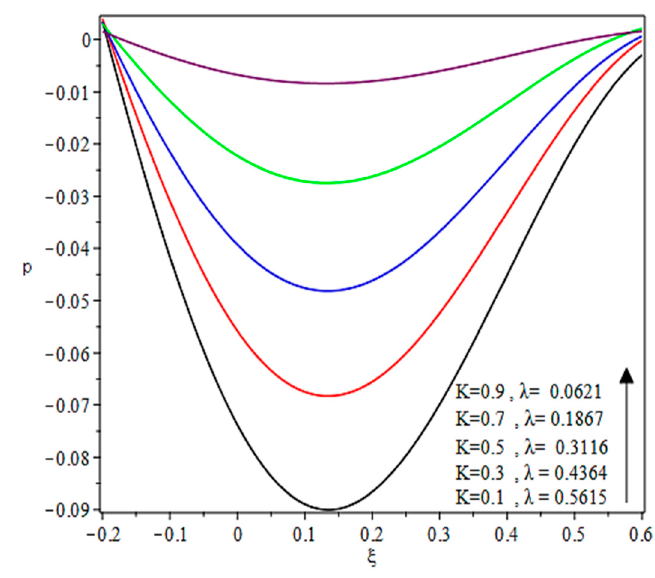
ζ = 1 ζ = 1 , = 0.2 M . , = 0.2 M .